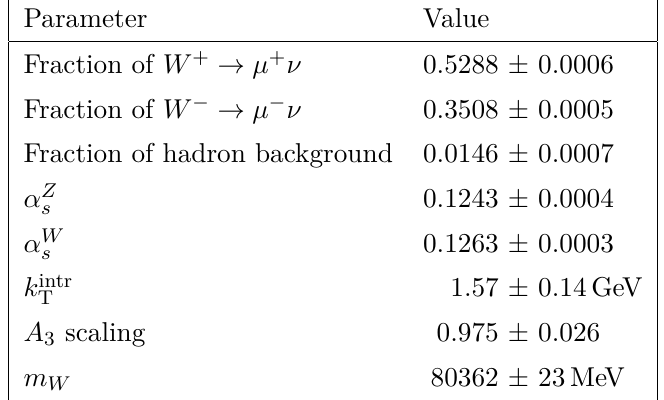
Table 3 . Fit results with the same default fit model used for the templates but with different models used for the pseudodata. The POWHEGPythia pseudodata correspond to α and k intr T